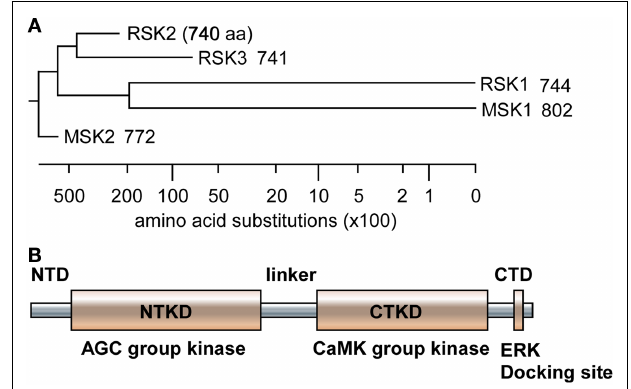
FIGURE 1 | Phylogenic tree and RSK2 domain structure . (A) The amino acid sequences of human RSK1, RSK2, RSK3, MSK1, and MSK2